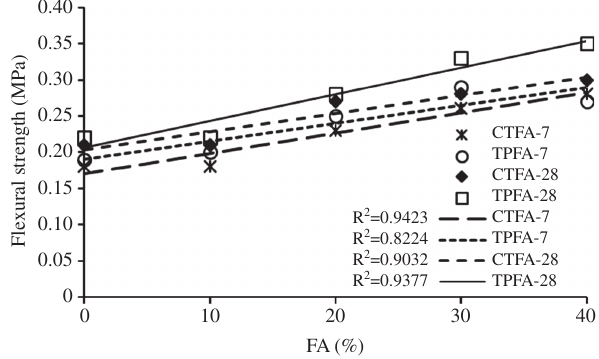
Figure 5 Flexural strength of specimens.